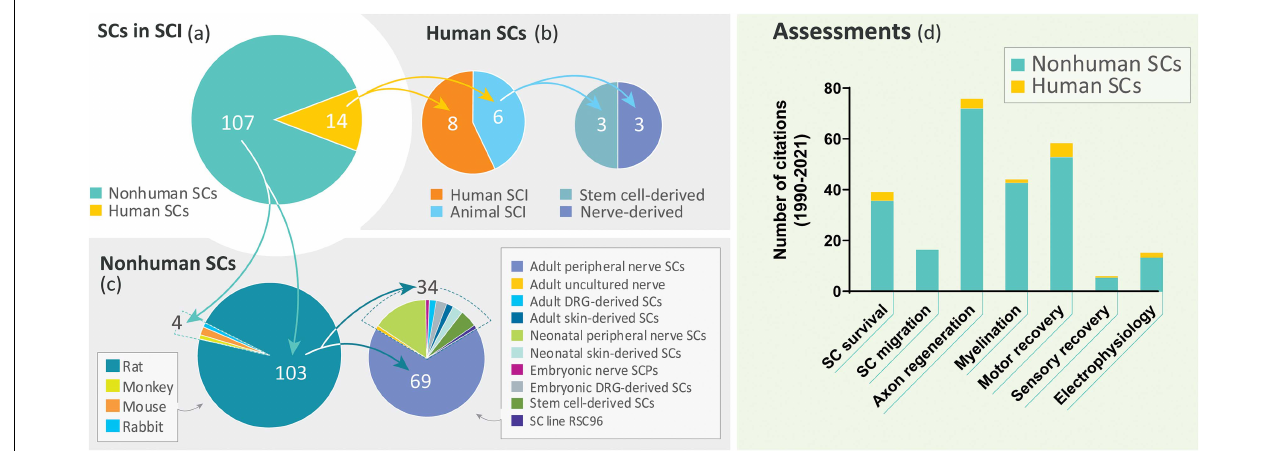
FIGURE 3 | Literature review on SC transplantation in SCI. A PubMed search using the terms “spinal cord injury” and “Schwann cell transplantation” as entry key words retrieved only 14 publications on the transplantation of hSCs (diverse origin) in non-clinical and clinical settings during the period 1990–2021 (a,b) . This time frame was selected to take into consideration that the first published study on SC transplants in SCI dates from 1990 (Kuhlengel et al., 1990b). Our search did not discriminate whether the SCs were nerve- or stem cell-derived but we excluded studies on ex-vivo transplants. Studies on non-human SCs from a variety of sources and developmental stages were extensive (88.4%) but the use of adult tissue-derived rat SCs was prevalent (c) . A categorization of available studies according to the type of assessments performed in basic and clinical studies combined is shown in (d) . The total number of scrutinized studies in the most relevant categories are noted in the pie